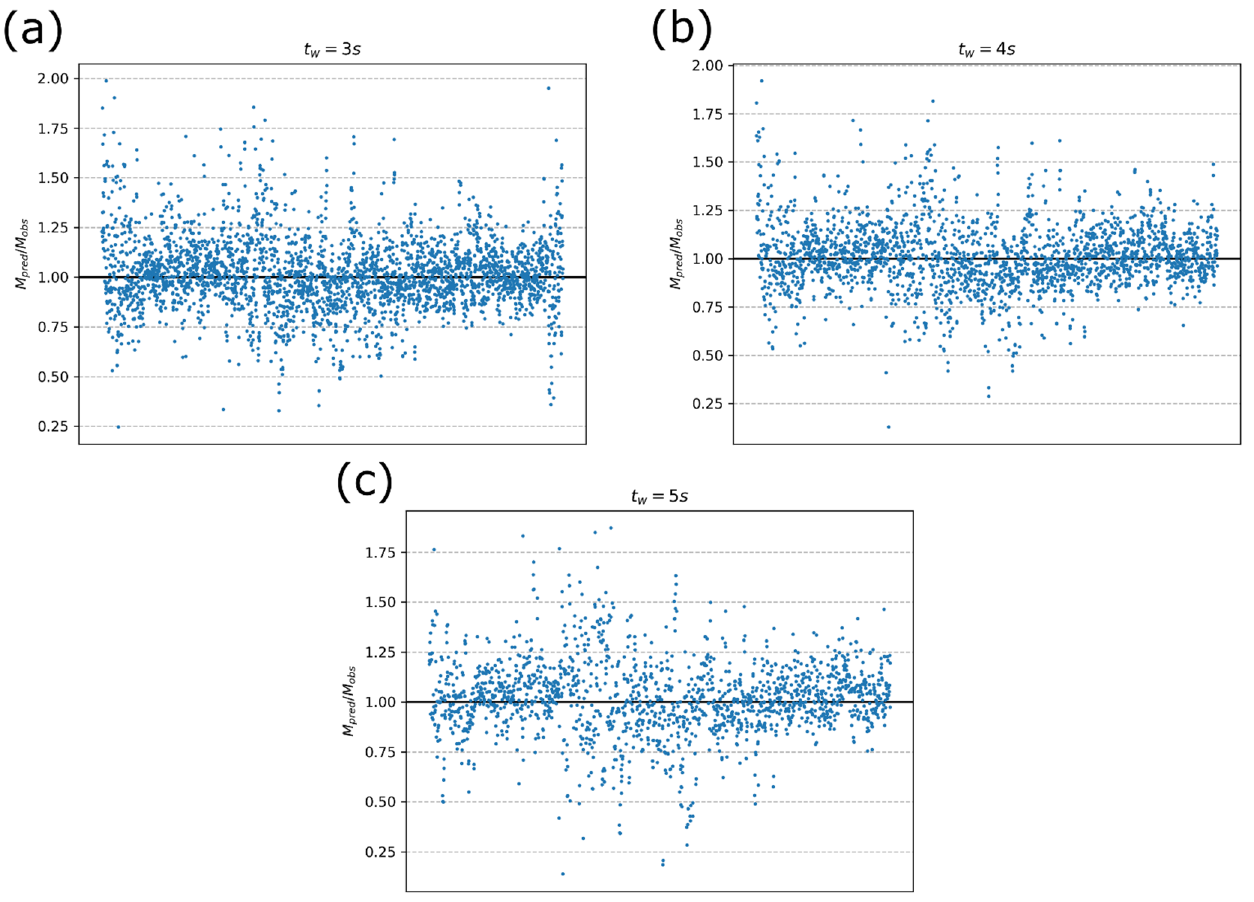
Figure A1. Predicted (M pred ) to observed (M obs ) magnitude ratio for the whole dataset, for signal windows of 3 s ( a ), 4 s ( b ) and 5 s ( c ).